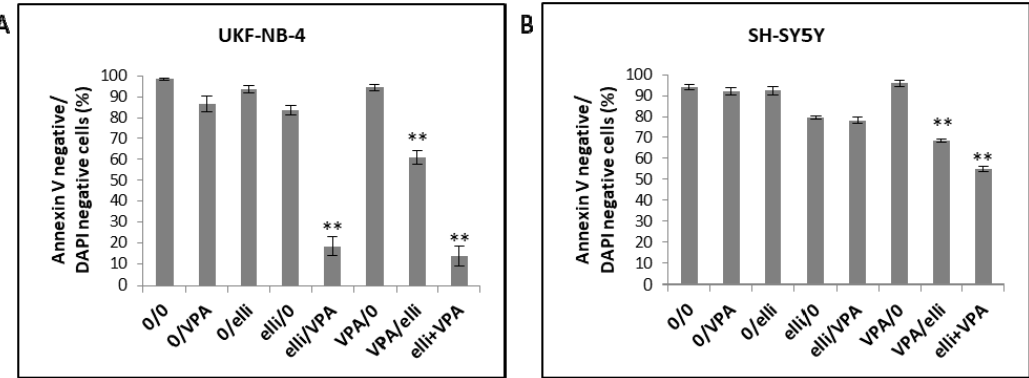
Figure 4. Viability of UKF-NB-4 ( A ) and SH-SY5Y ( B ) cells after incubation with 5 µM ellipticine (elli) or 1 mM valproic acid (VPA) and their various combinations. Experimental treatment conditions are described in Table 1. Values are mean ± SD from three independent experiments. ** p < 0.01 as compared to elli/0 group (ANOVA with post-hoc Tukey HSD Test).